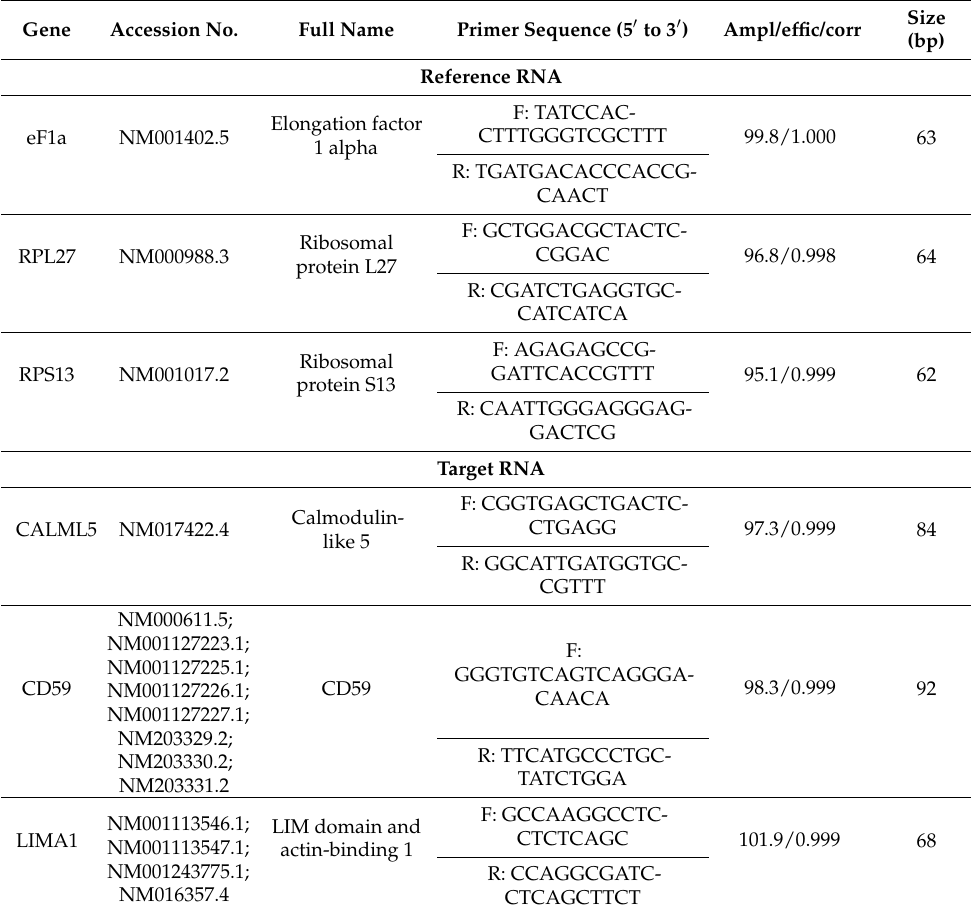
Table 4. Primers for RT-qPCR